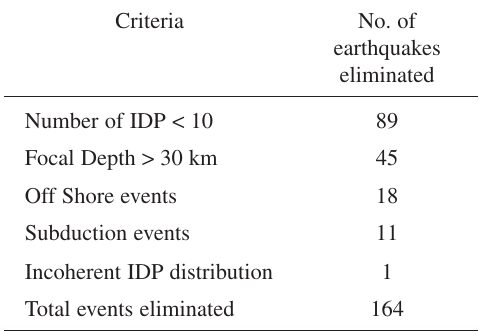
Table IV. Criteria used for selecting earthquake records from 201 events with I 0 ≥ 8.